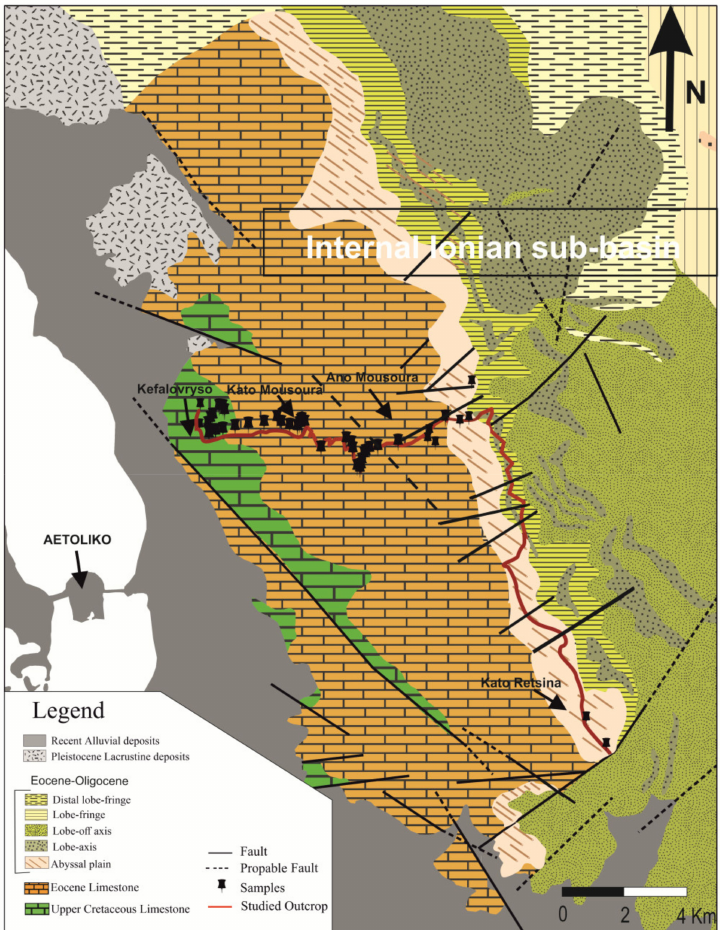
Figure 3. Geological map of the studied area (modified from [4]). Black pins indicate the position of the samples, and the red line indicates the road from Kato-Retsina to Kefalovryso.The